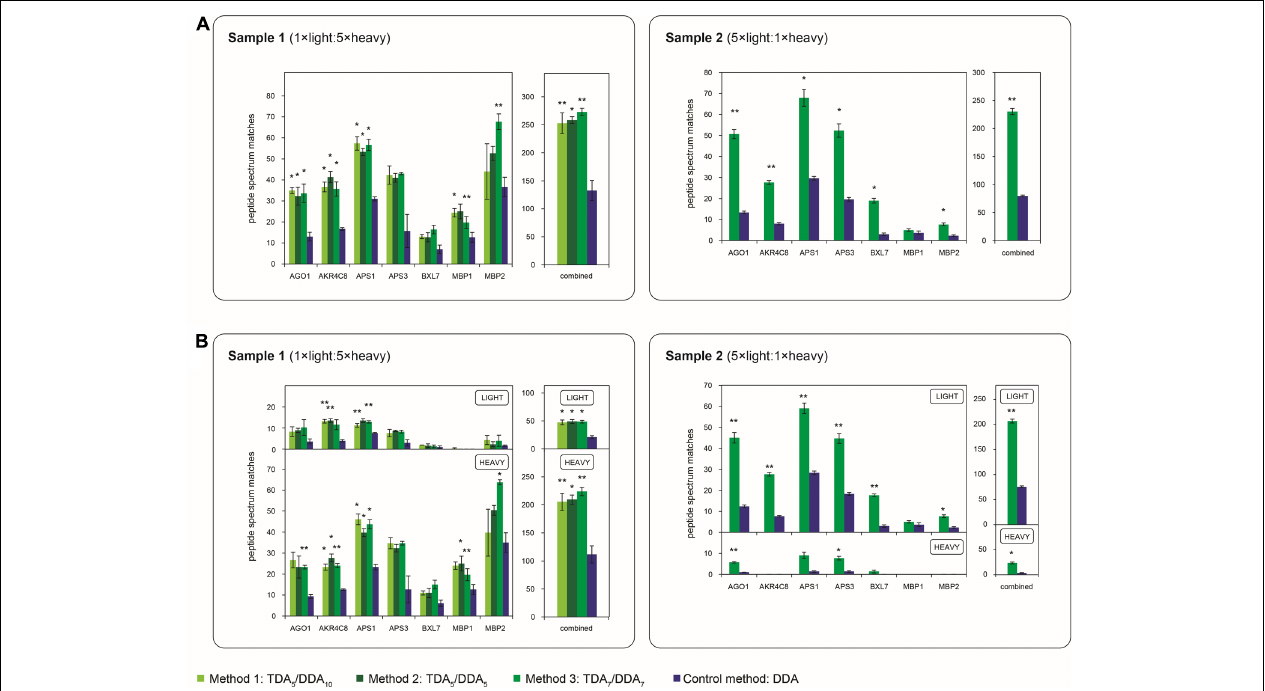
FIGURE 3 | Average numbers of peptide spectrum matches obtained for the miRNA target proteins of Table 1 in TDA/DDA and DDA control method experiments. (A) Average peptide spectrum matches for each individual targeted protein, and for all targeted proteins combined, per technical replicate in each batch of LC-MS/MS experiments conducted on sample 1 (left) and sample 2 (right). (B) The same data shown separately for light (above) and heavy (below) peptide spectrum matches. Statistically significant differences between TDA/DDA and DDA control method experiments, as determined using 2-tailed t -tests, are labeled ∗ p < 0.05 or ∗∗ p <